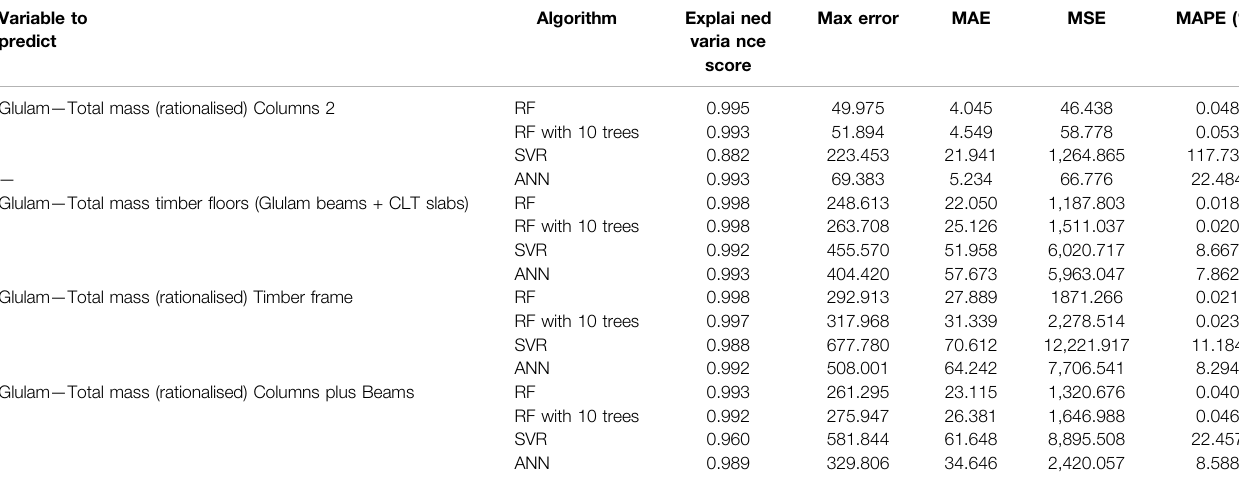
TABLE 4 | Average cross-validation error for results on glulam. Variable to